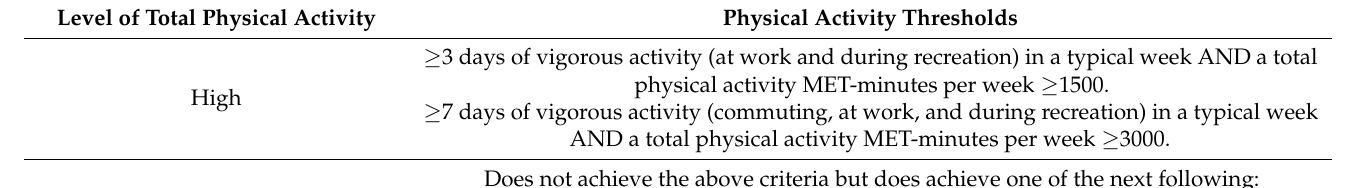
Table 1. Total physical activity levels and classification criteria recommended by Global Physical Activity